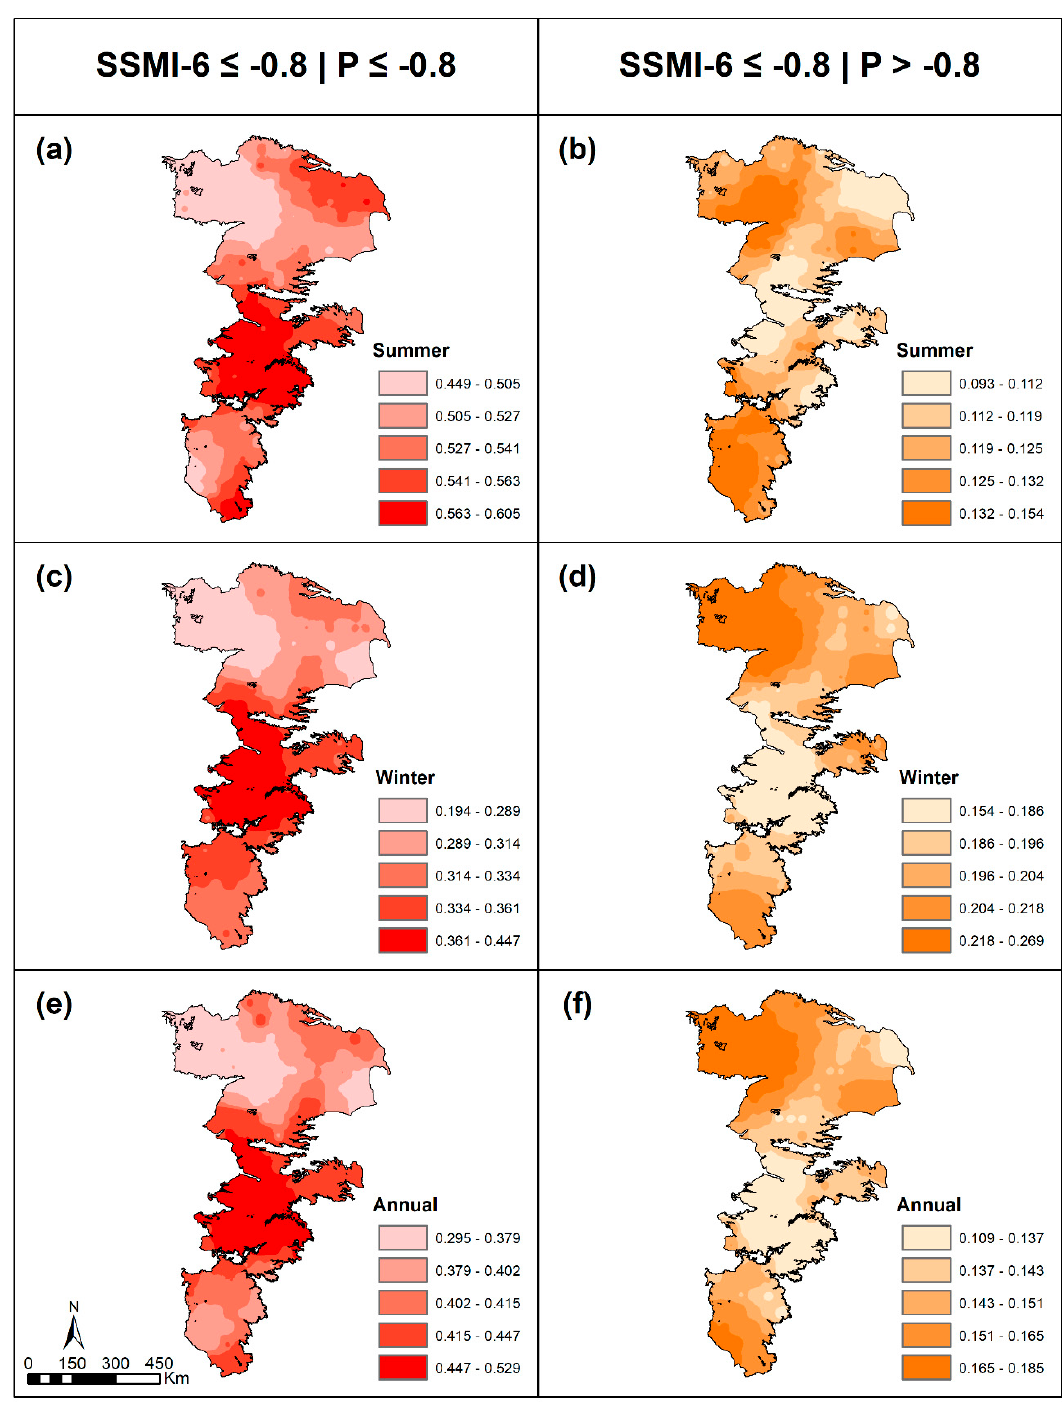
Figure 6. Risk of moderate agriculture drought or higher using SSMI6 given standardized precipitation being under (left panel) and no under (right panel) ( a – f ). being under (left panel) and no under (right panel) ( a – f